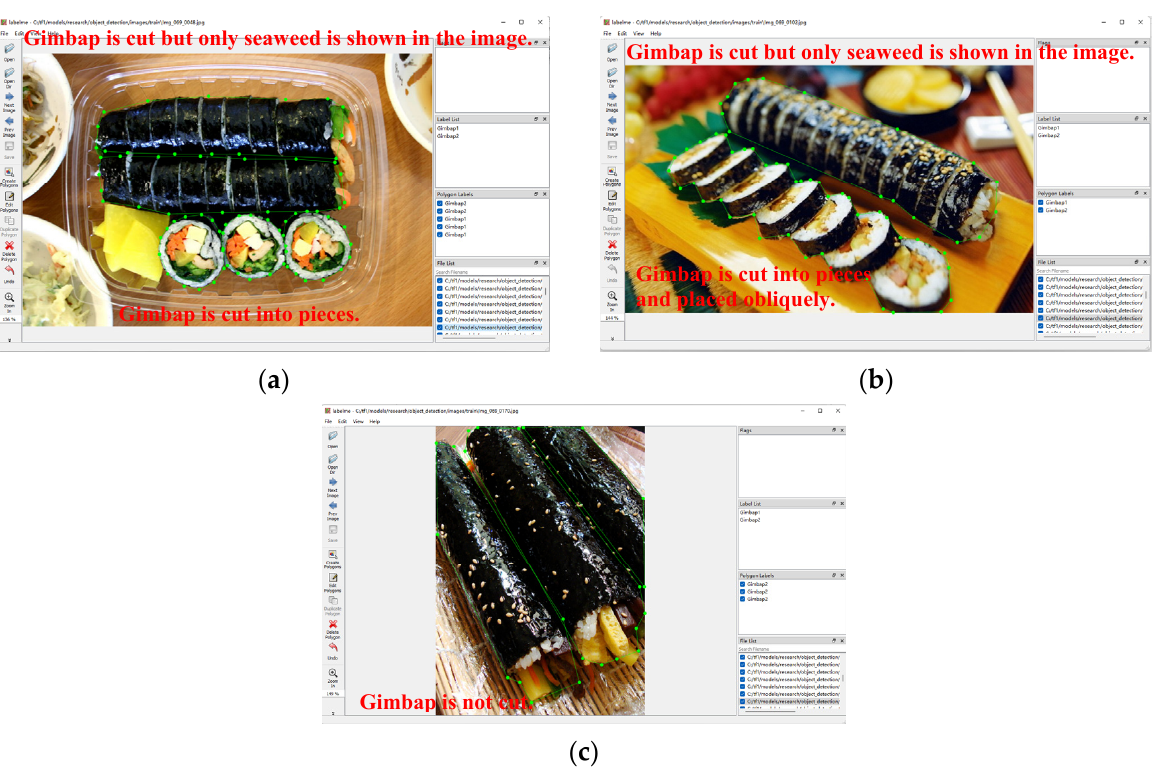
Figure 3. Classification of Gimbap. ( a ) The Gimbap is cut into pieces, the vegetables and rice are shown in the image, and it will be labeled as Gimbap1; ( b ) the Gimbap is cut into pieces and placed obliquely, it will be labeled as Gimbap1; ( c ) the roll of Gimbap is not cut and seaweed is shown in the image, it will be labeled as Gimbap2.